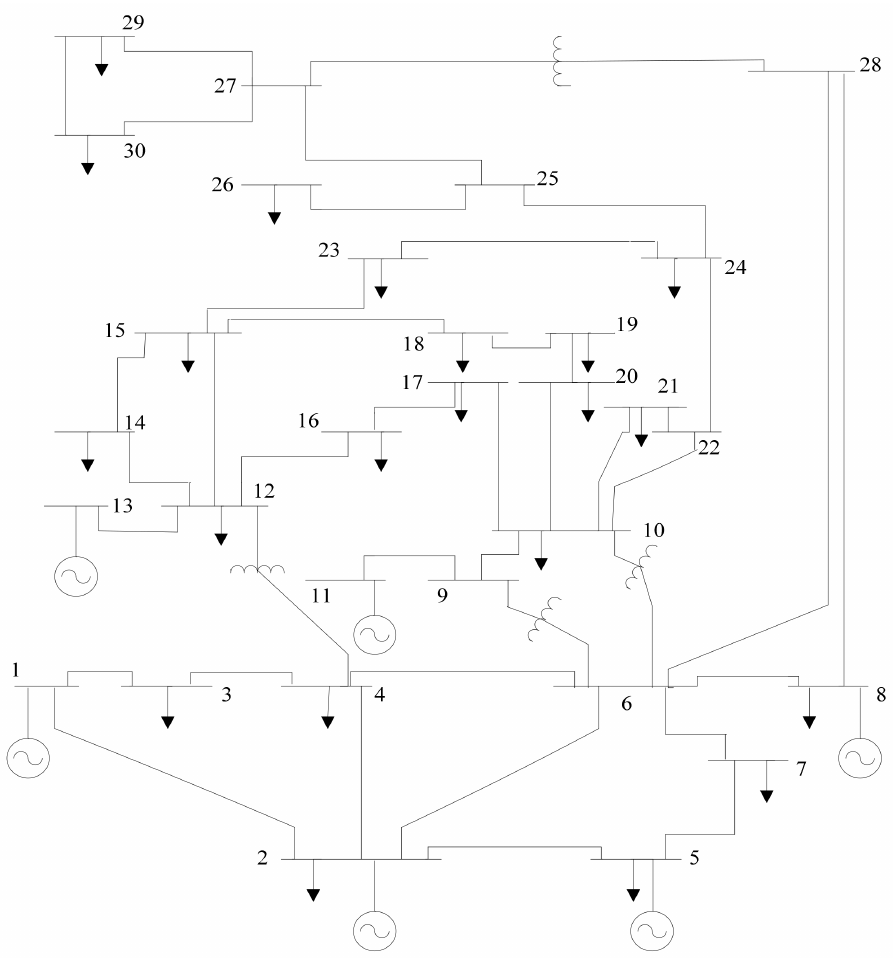
Figure 4. The layout of the IEEE 30-bus